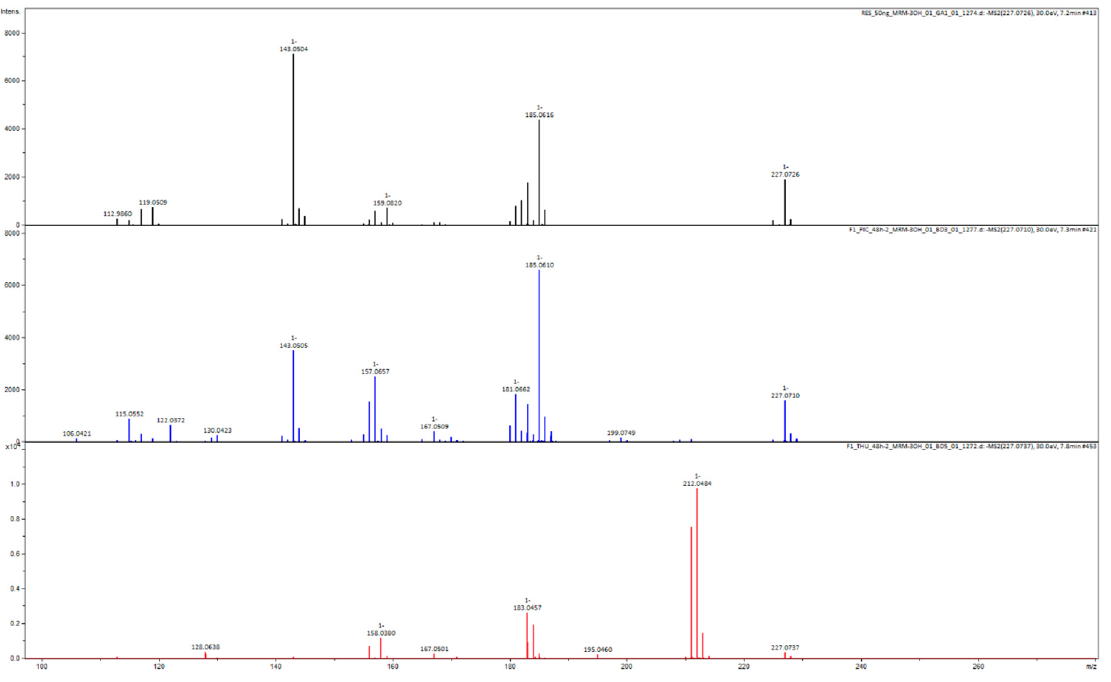
Figure A1. MS/MS spectra of resveratrol, 3,3 ′ ,4 ′ -trihydroxystilbene/3 ′ ,4 ′ ,5-trihydroxystilbene and isoresveratrol